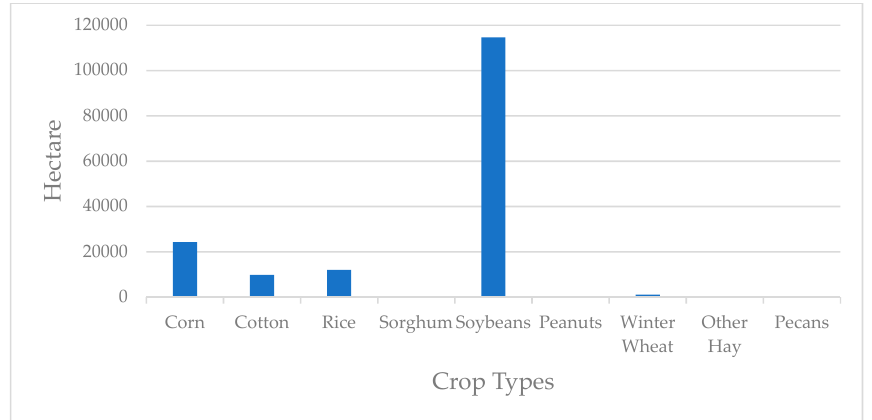
Figure 11. Comparison of SMAP derived inundation acreage of the Mississippi Flood (March 2016) over major crop types.